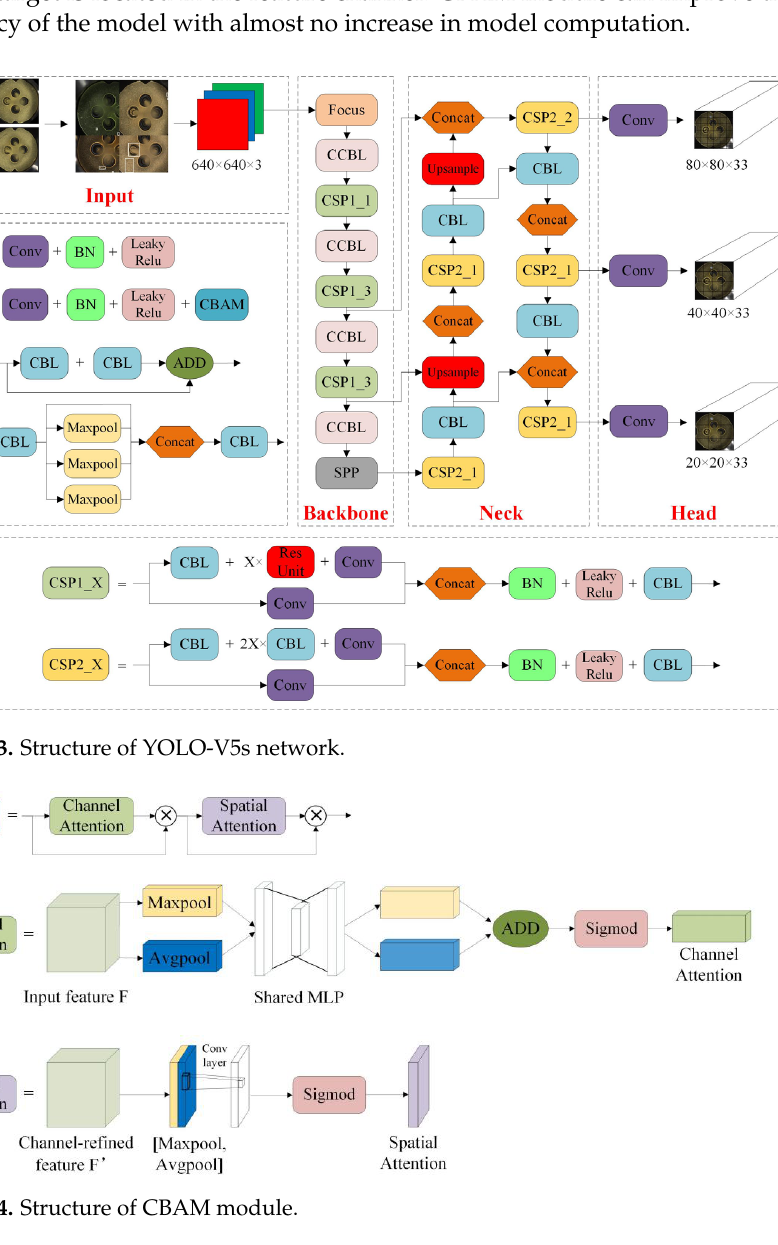
Figure 4. Structure of CBAM module.